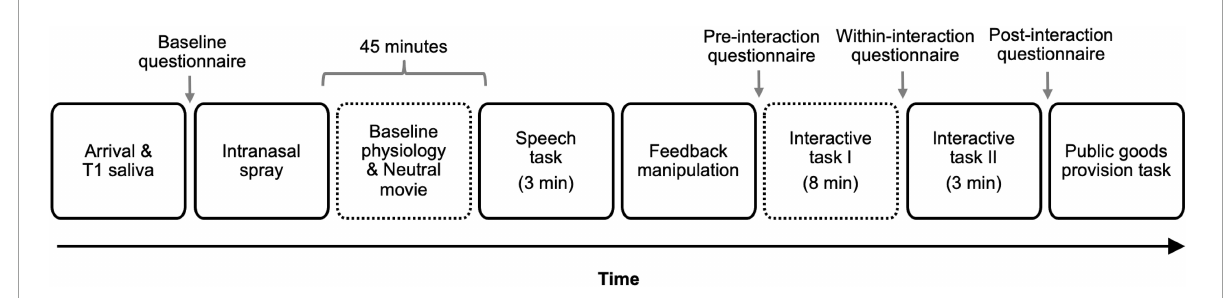
FIGURE1 Study timeline. T1 indicates Time 1. The number in parenthesis indicates the duration of the task for tasks with fixed duration. Time 2 [T2] and Time 3 [T3] saliva samples were obtained 18 and 33 min following the onset of the first interactive task (i.e., taboo game), respectively. Dotted outlines indicate the times when cardiovascular responses were assessed. Reactivity indices were computed on three physiological parameters (heart rate, pre-ejection period, and cardiac output) by subtracting participants’ baseline responses obtained during the last minute of the initial resting period from the physiological responses obtained during the first segment of the interactive